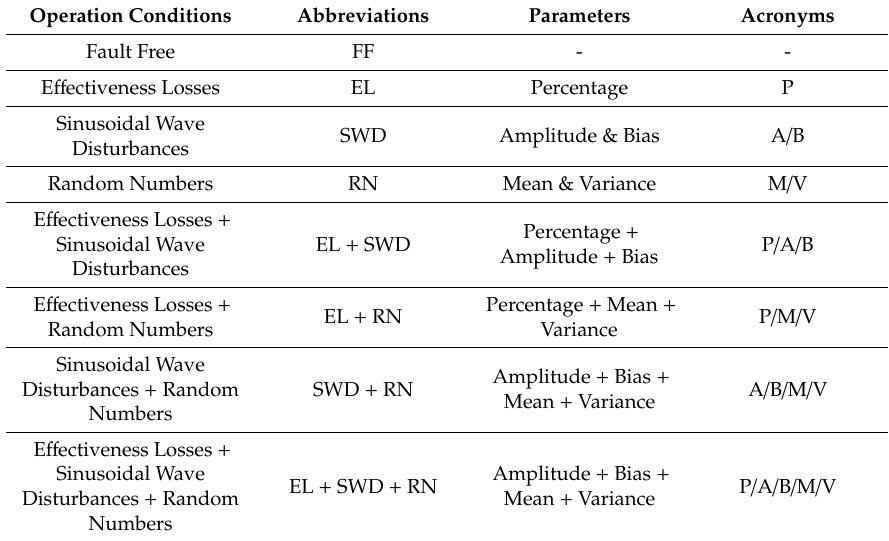
Table 3. Operation Conditions, Parameters, and Acronyms for 4.8 MW Wind Turbine Systems.